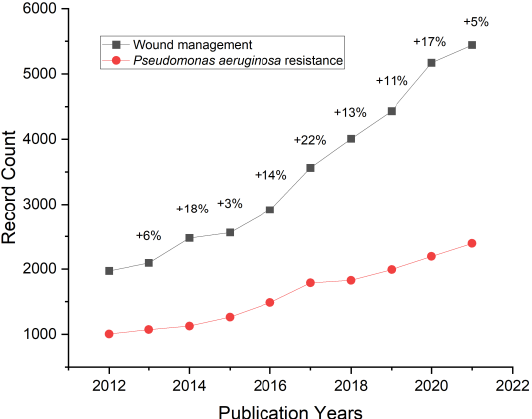
Figure 1. The trend in the number of scientific works published in the past decade on the topic of wound management. Percentages indicate the increase in the number of scientific papers each year compared to the preceding year. Visualized based on the data from Clarivate Analytics Web of Sci- ence (t opic keywords: “ w ound management” and “ Pseudomonas aeruginosa resistance”, access date: 13 November 2022).